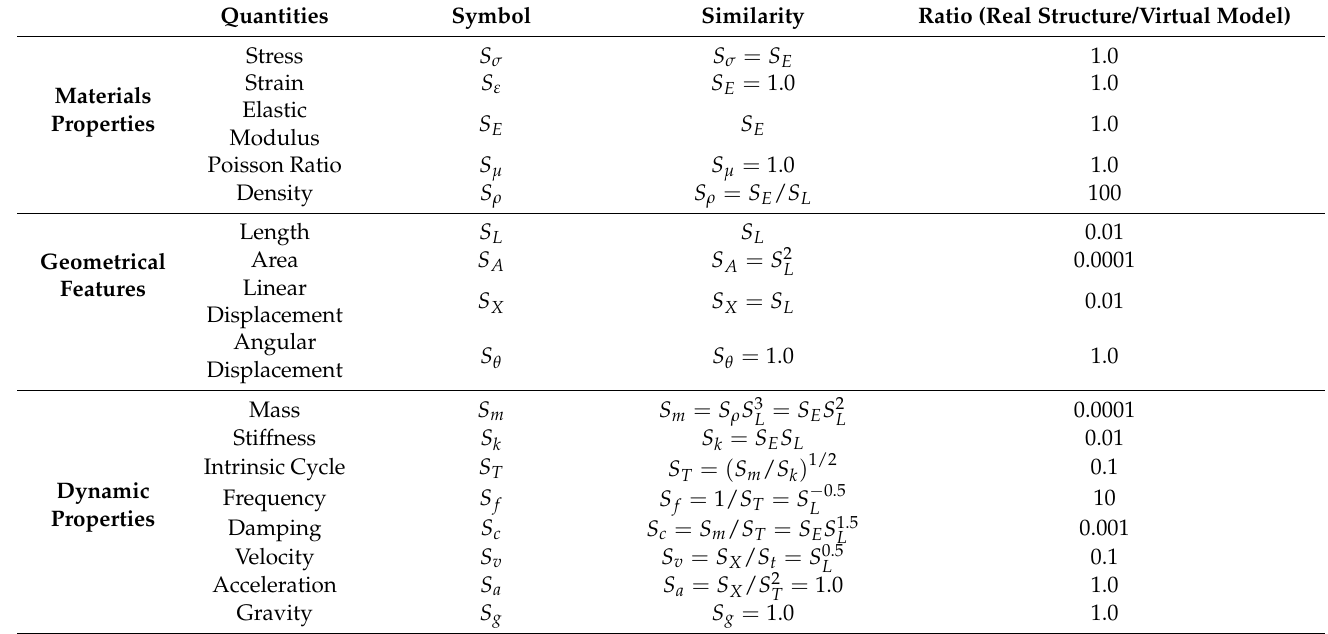
Table 1. Similarity relation between the design model and the real MSCSS